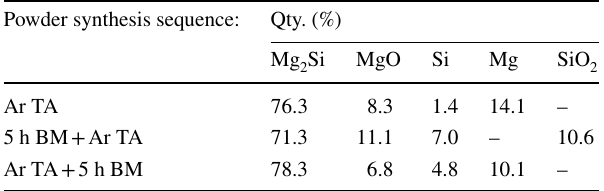
Table 1 XRD phases quantification of powders processed under dif- ferent conditions Powder synthesis